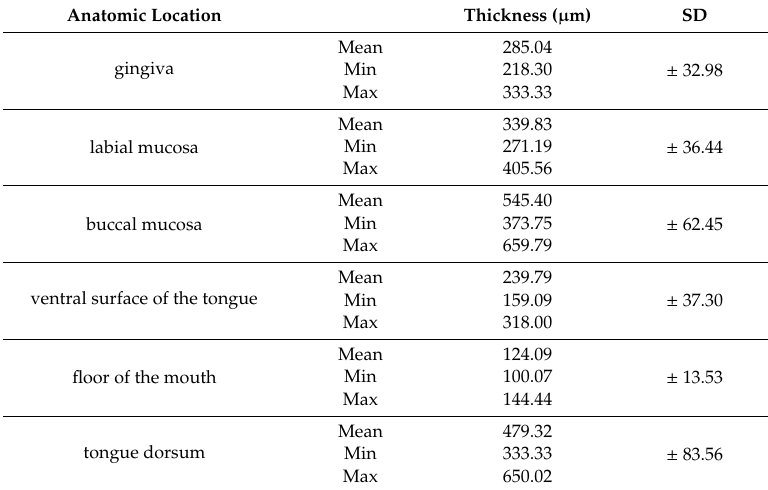
Table 1. Values of epithelial thickness within the oral